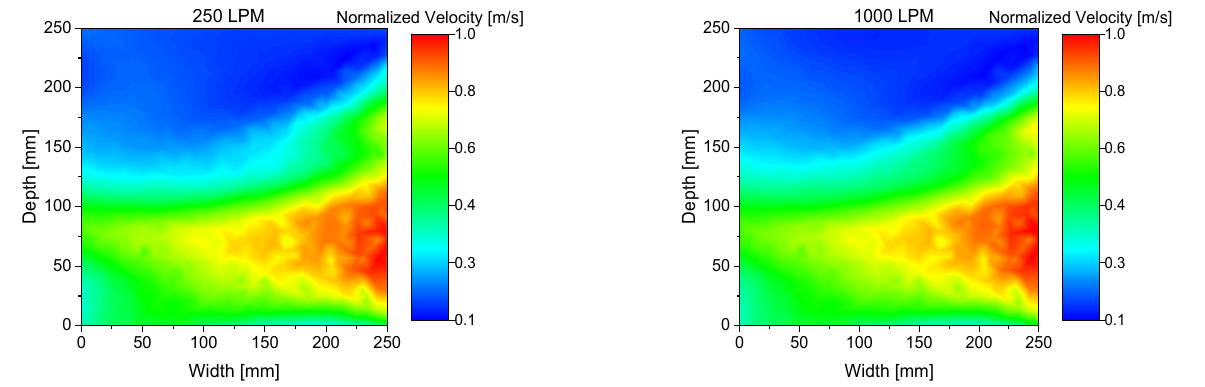
Figure 6. Velocity profiles normalized by maximum velocity in the center plane for different gas flow rates. ( Left ): 250 LPM and maximum velocity of 1.59 m/s. ( Right ): 1000 LPM and maximum velocity of 6.36 m/s.